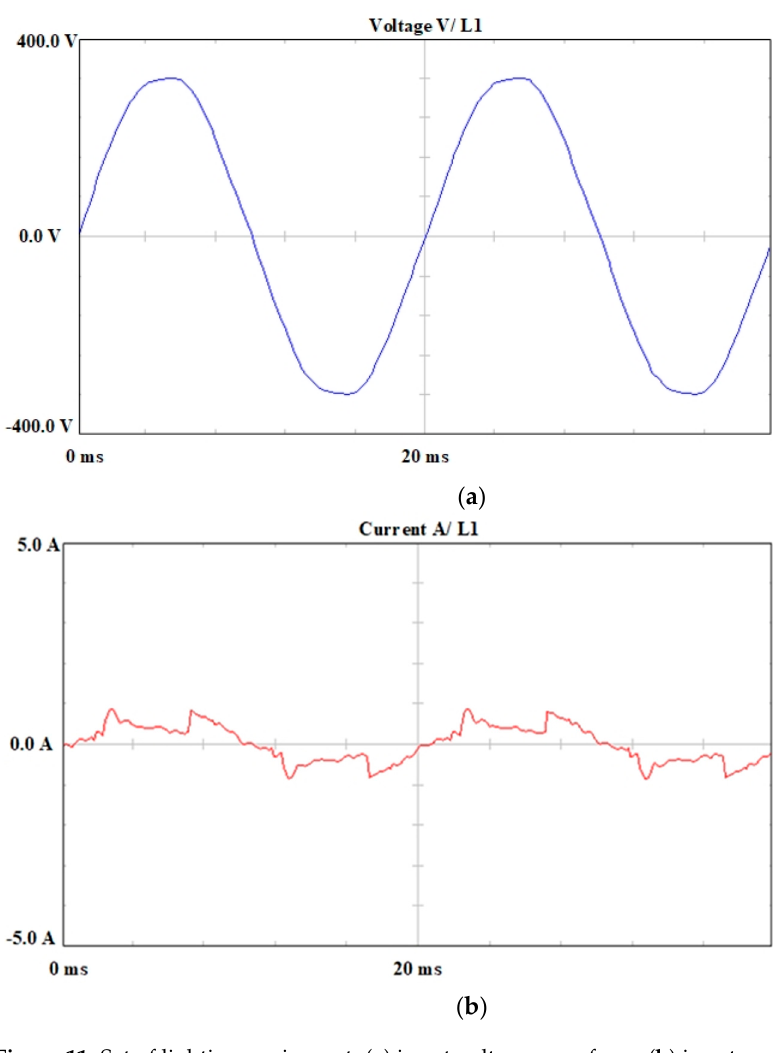
Figure 11. Set of lighting equipment: ( a ) input voltage waveform, ( b ) input current waveform.